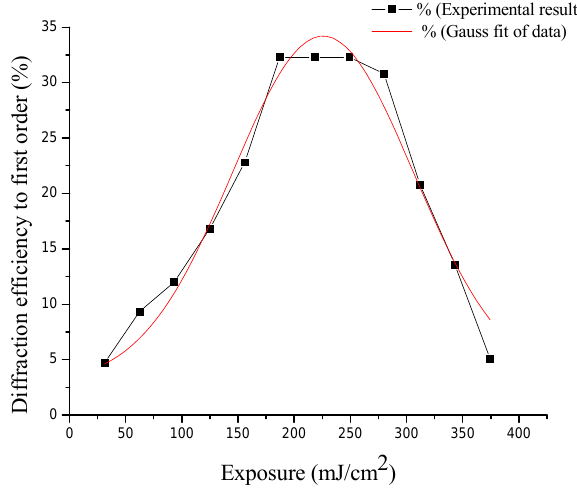
Figure 7. The experimental diffraction efficiency, with respect to recording energy from holographic gratings measured at the Bragg